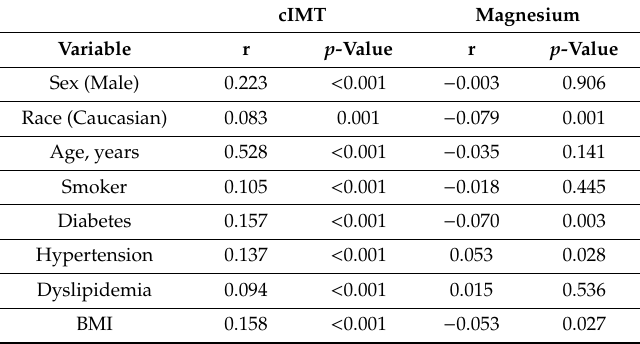
Table 2. Bivariate correlation coe ffi cients between cIMT and Magnesium levels with other